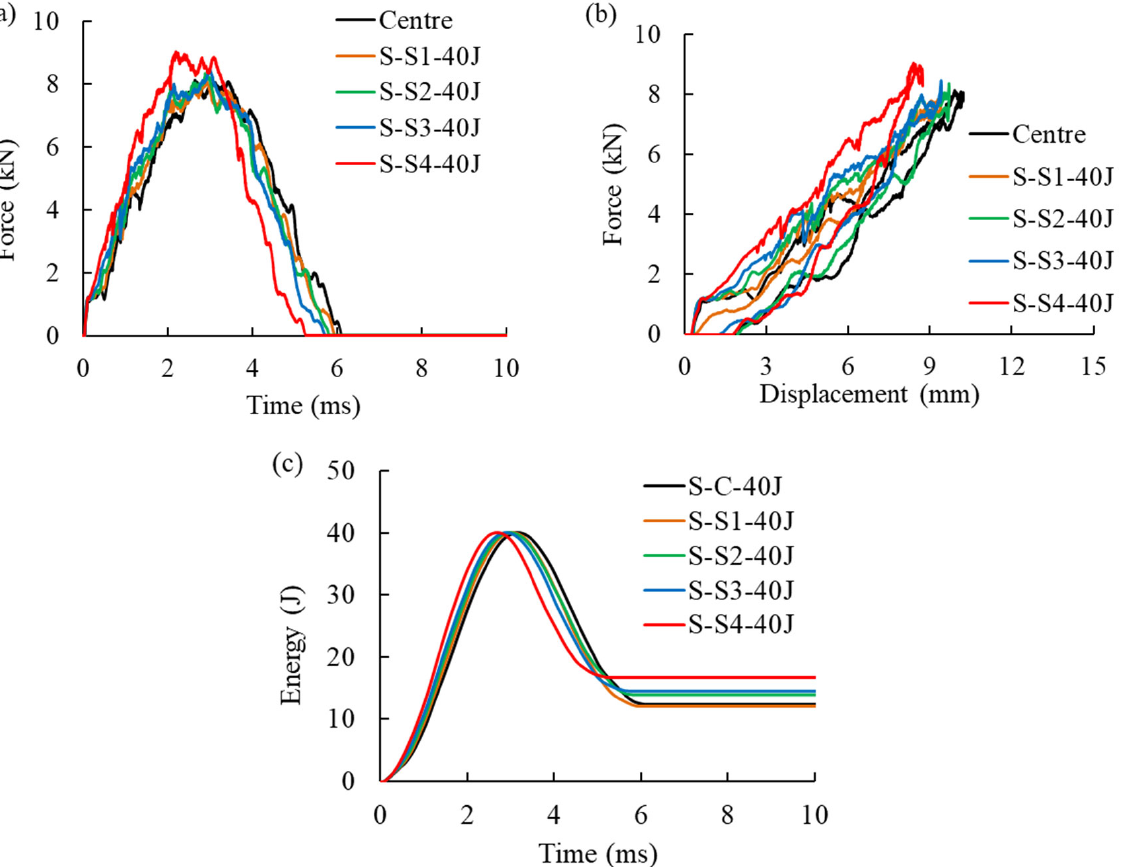
Figure 7. Comparison of force–time ( a ), displacement–time ( b ), and energy–time ( c ) curves for 40 J impact at the center and off-center